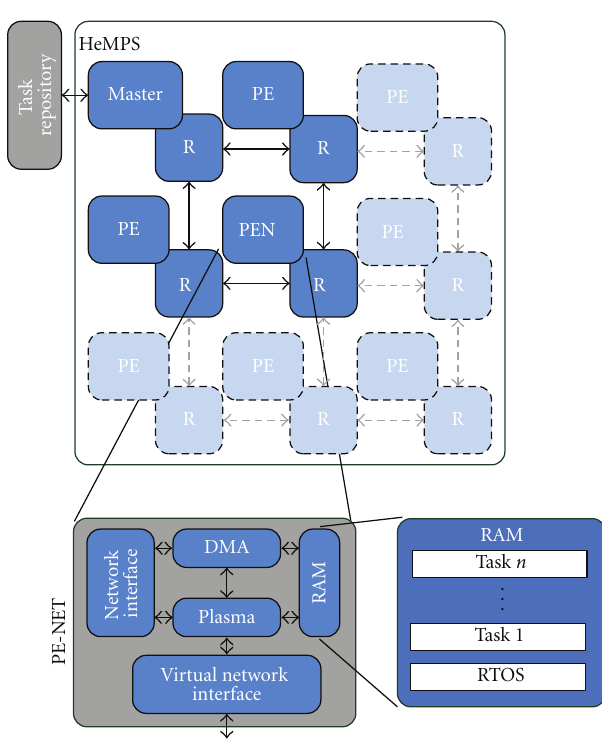
Figure 3: HeMPS with virtual network interface extension.